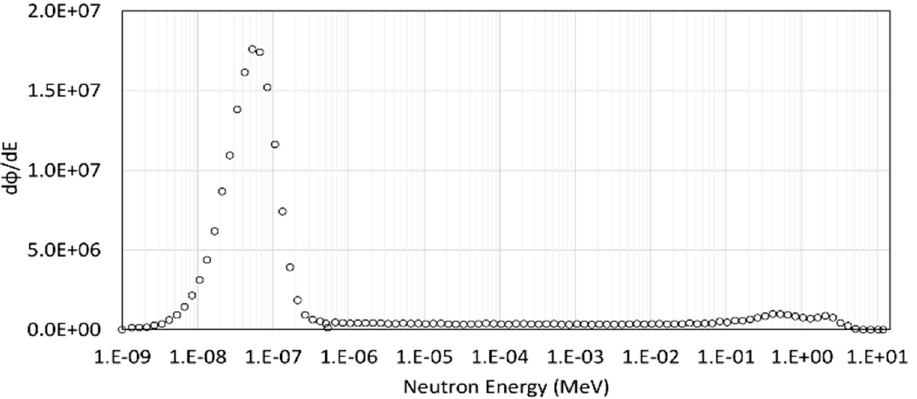
Figure 2. Measured neutron spectrum in HOTNES reference point with polyethylene ceiling in place. Errors are smaller than graphical symbols